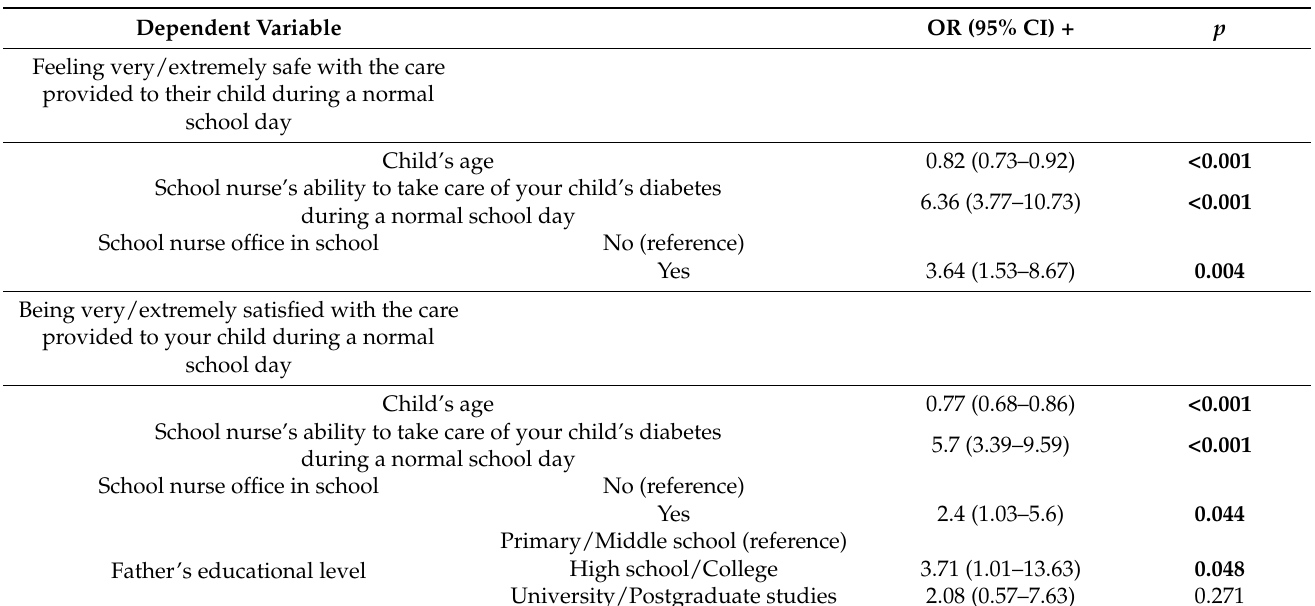
Table 5. Multivariate logistic regression results, with feeling very/extremely safe and satisfied with the care provided to their child as dependent